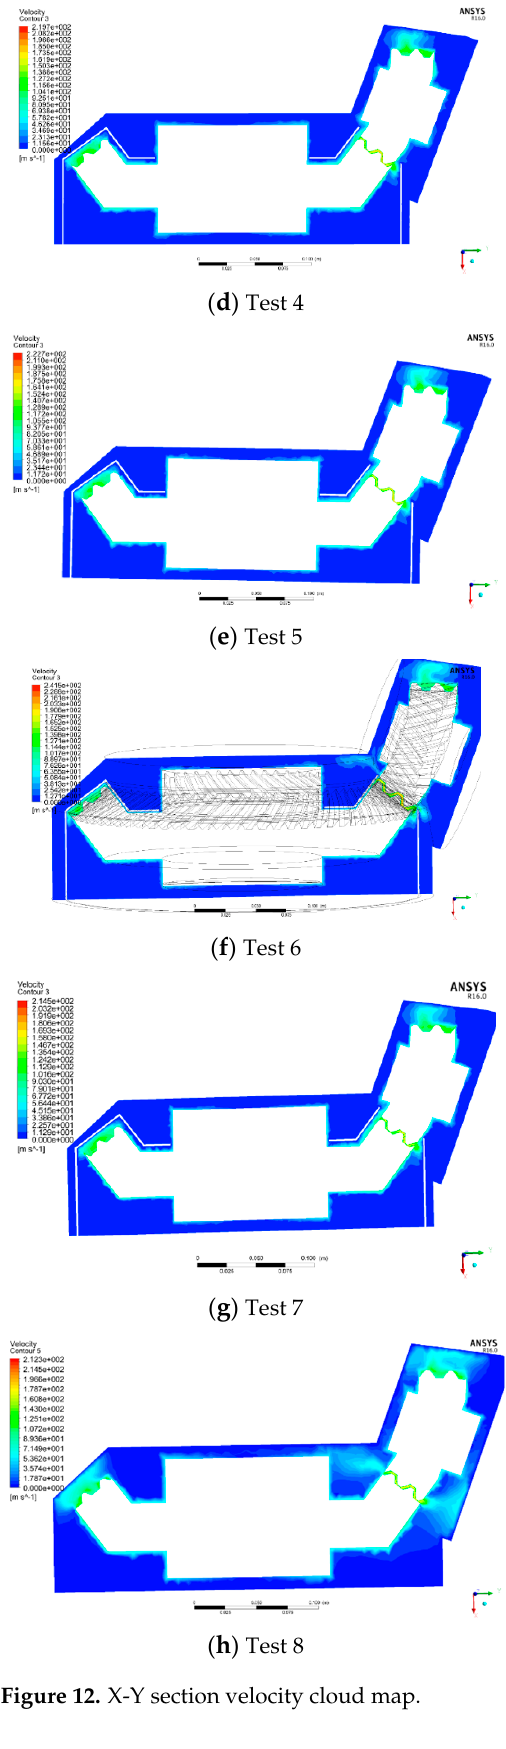
Figure 12. X-Y section velocity cloud map.